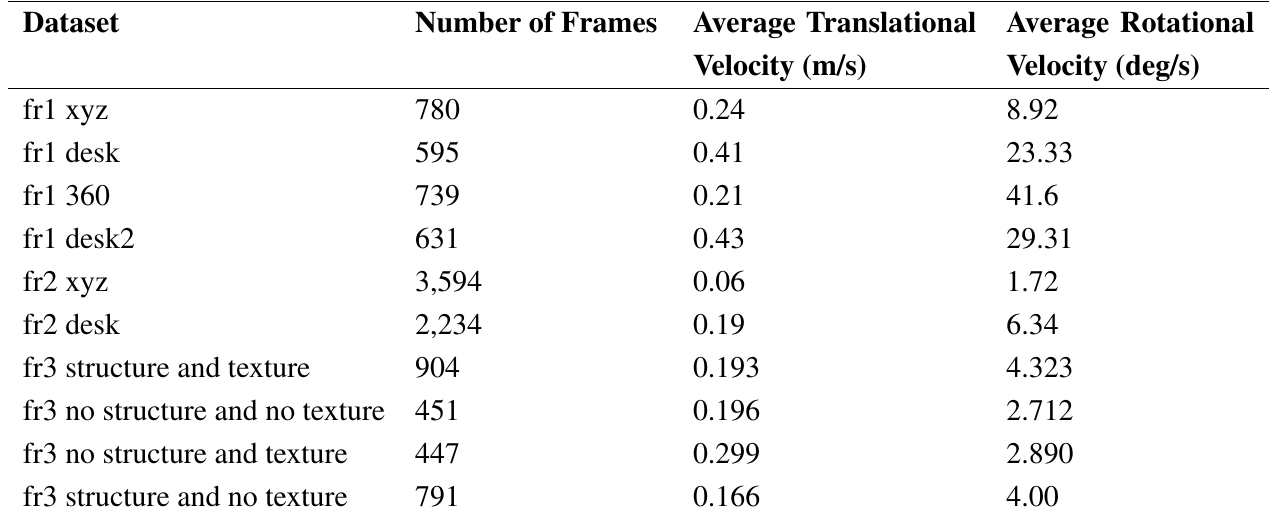
Table 1. The number of frames and the average translation and rotation velocities of the used